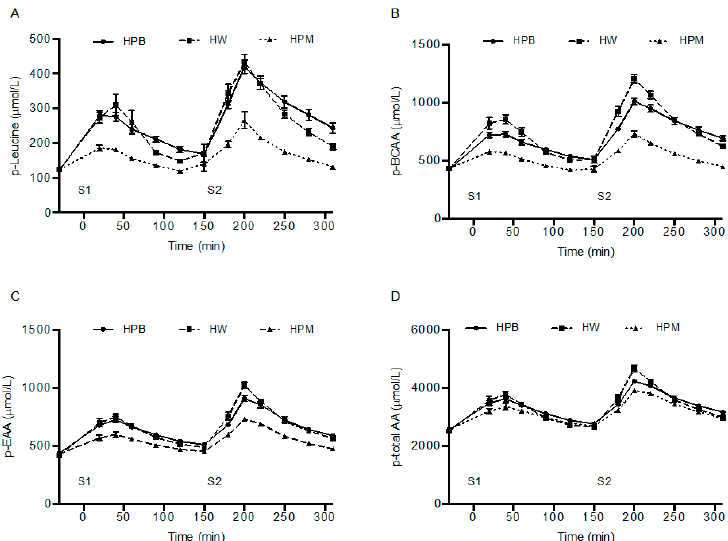
Figure 4. Mean ± SEM postprandial p-leucine ( A ), p-BCAA ( B ), p-EAA ( C ) and p-total amino acid ( D ) concentrations after serving 1 and serving 2, n = 18. Time to peak and peak p-leucine concentrations were analyzed using linear mixed-e ff ects models with treatment order, age and baseline p-leucine concentrations as fixed e ff ects and with subject-specific random e ff ects. Data on p-leucine, p-BCAA, p-EAA and p-total amino acids were analyzed as AUC serving1 and AUC serving2 using a linear mixed-e ff ects model with a serving-treatment interaction and with treatment order and age as fixed e ff ects and with subject-specific random e ff ects. HPB, hydrolyzed porcine blood protein; HPM, hydrolyzed porcine muscle protein; HW, hydrolyzed whey protein, S1, serving 1 (15 g protein); S2, serving 2 (30 g protein served with a mixed